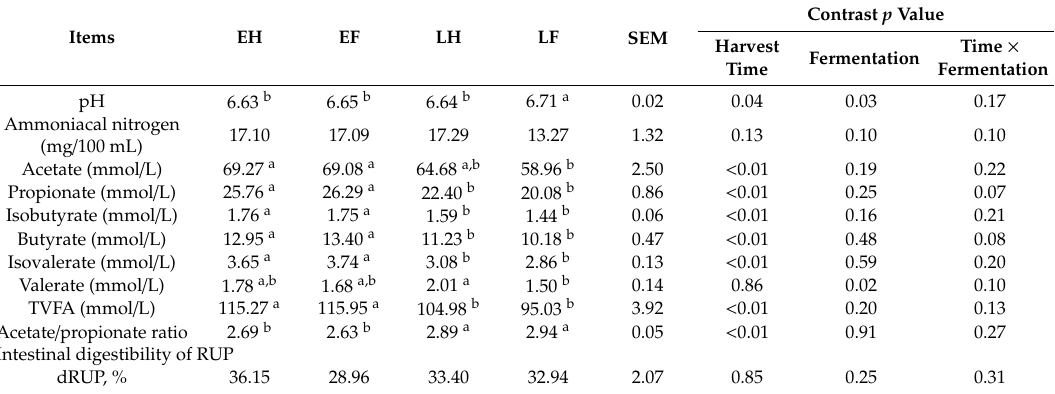
Table 6. E ff ects of harvest time and microbial anaerobic fermentation treatment on situ rumen fermentation and intestinal digestion of whole Zhang hybrid millet.